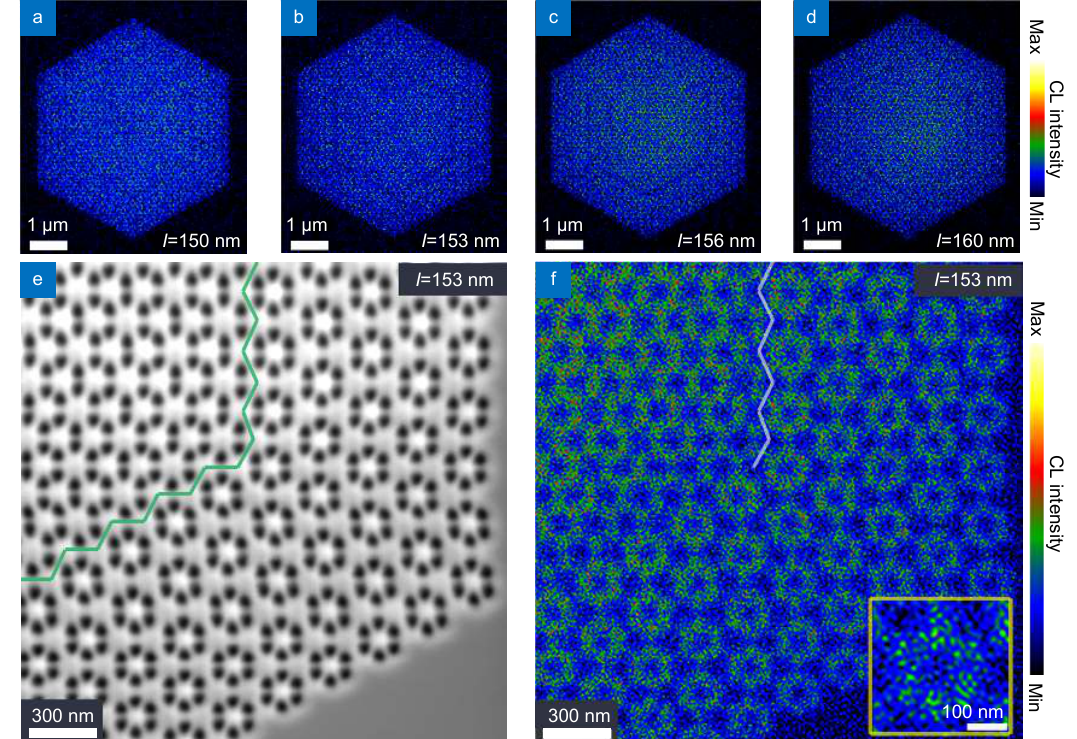
Fig. 3 | Deep-subwavelength LDOS imaging of the dark line of edge state. ( a - d ) CL mapping of four samples with increasing l to show the change of structure radiative LDOS. ( e ) Corner SEM image of the same sample in (b), the interface of two PhCs is marked with a solid green line. ( f ) Corresponding CL mapping of ( e ). The right part of the interface of two PhCs is marked with a solid white line. The inset is a detailed CL im- age of a single unit